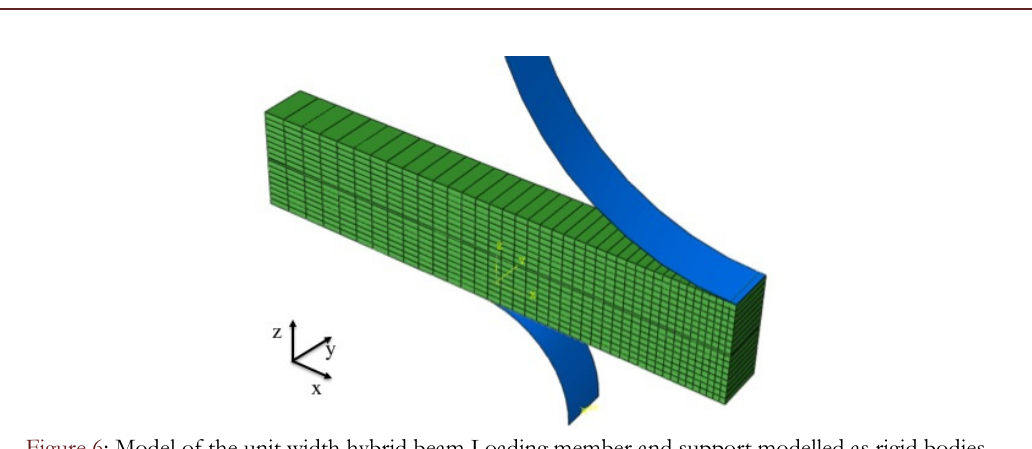
Figure 6: Model of the unit width hybrid beam Loading member and support modelled as rigid